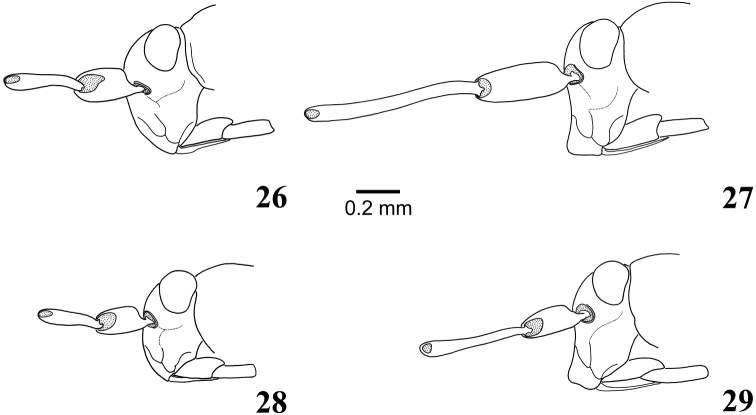
Male head in lateral view: 26Myrmecophyesarmeniacus Drapolyuk, 1989 27Myrmecophyesnasutus Drapolyuk, 1989 28Myrmecophyesheterocerus Horváth, 1927 29Myrmecophyestomi sp. n.